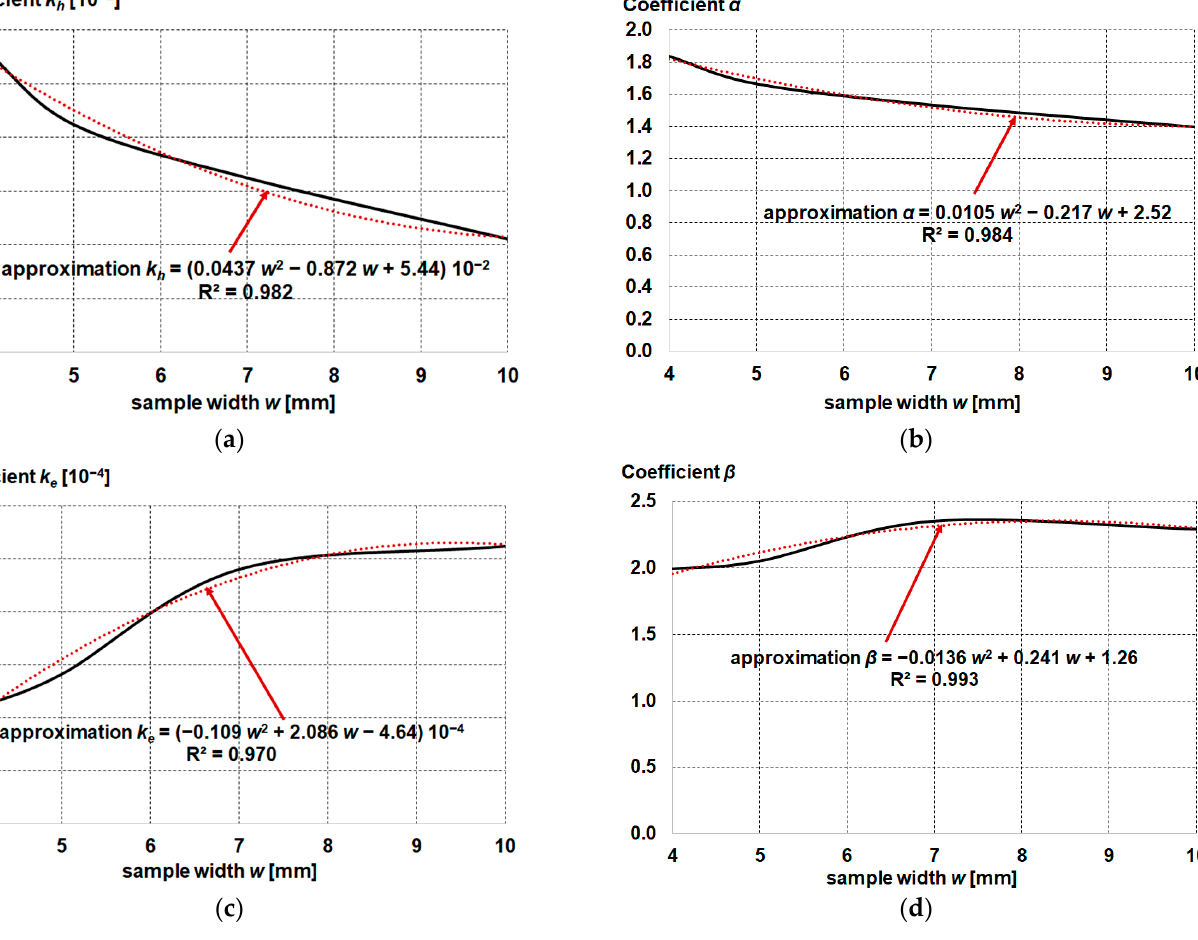
Figure 9. Approximation of the coefficient ( a ) k h ; ( b ) α ; ( c ) k e ; ( d ) β . for sheets punched with a guillotine with a width of 4 mm to 10 mm for the frequency range 5–50 Hz and induction range up to 0.6 T (red dotted line - approximation).